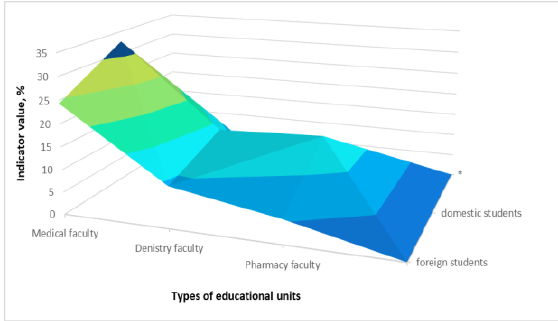
Figure 3. Comparative analysis of activity among domestic and foreign students in information and educational